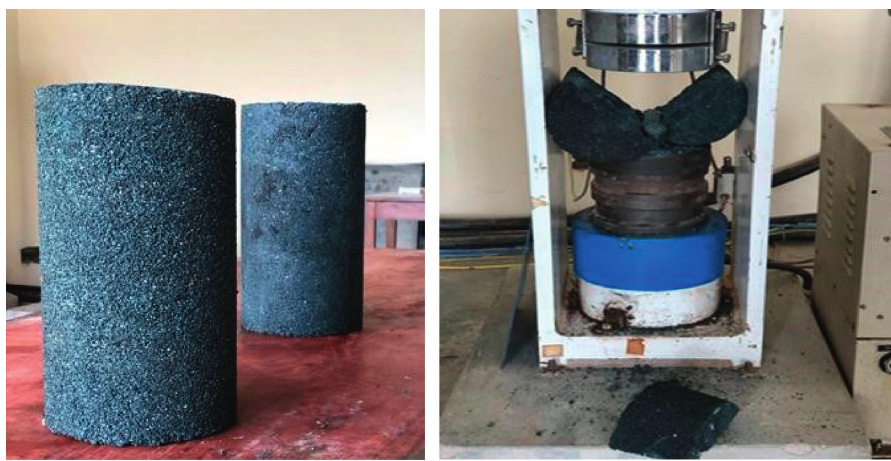
Figure 11: Split tensile test of plastic sand bricks. Table 3: Compressive strength test on different ratios of plastic and sand.